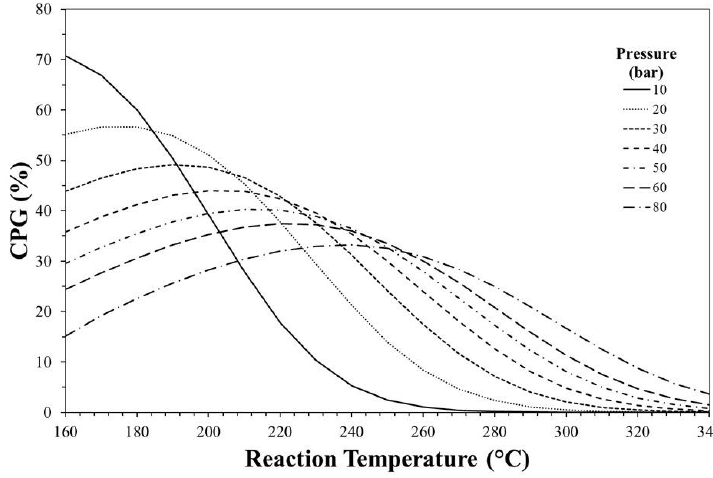
Figure 8. CO 2 conversion percentage gain (CPG) as a function of reaction temperature and pressure.